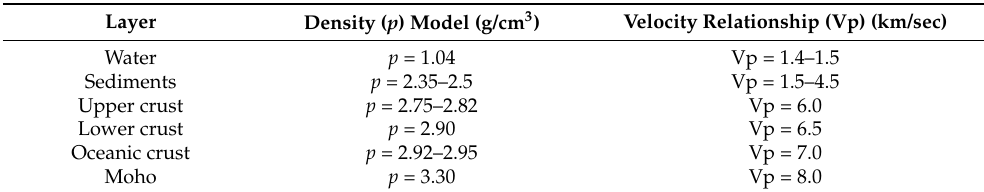
Table 1. Density and velocity relationship in g/cm 3 unit and (km/s), respectively. Adapted from Birch empirical functions